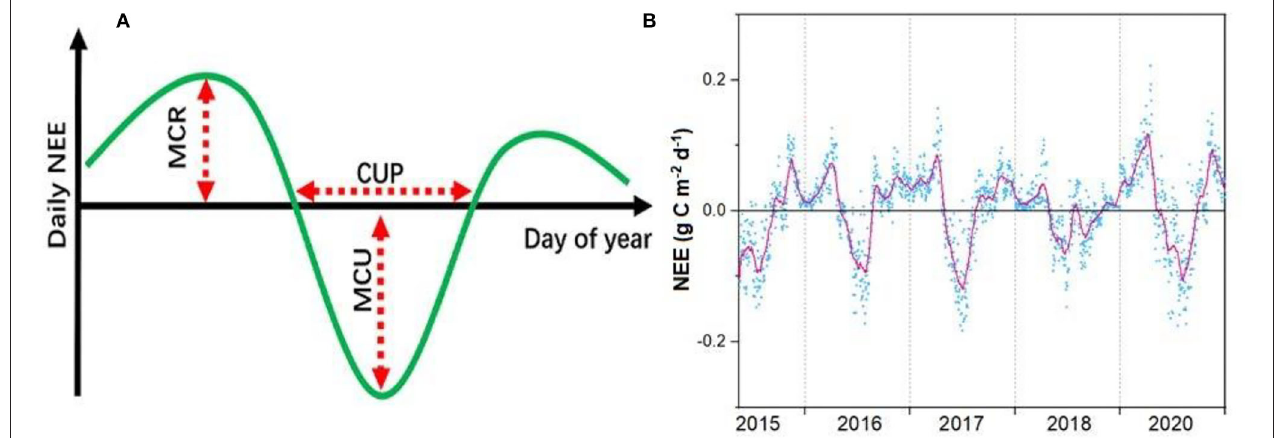
FIGURE 2 | Conceptual figure of maximum CO 2 uptake (MCU), CO 2 uptake period (CUP), and maximum CO 2 release (MCR) in determining the changes in annual net ecosystem CO